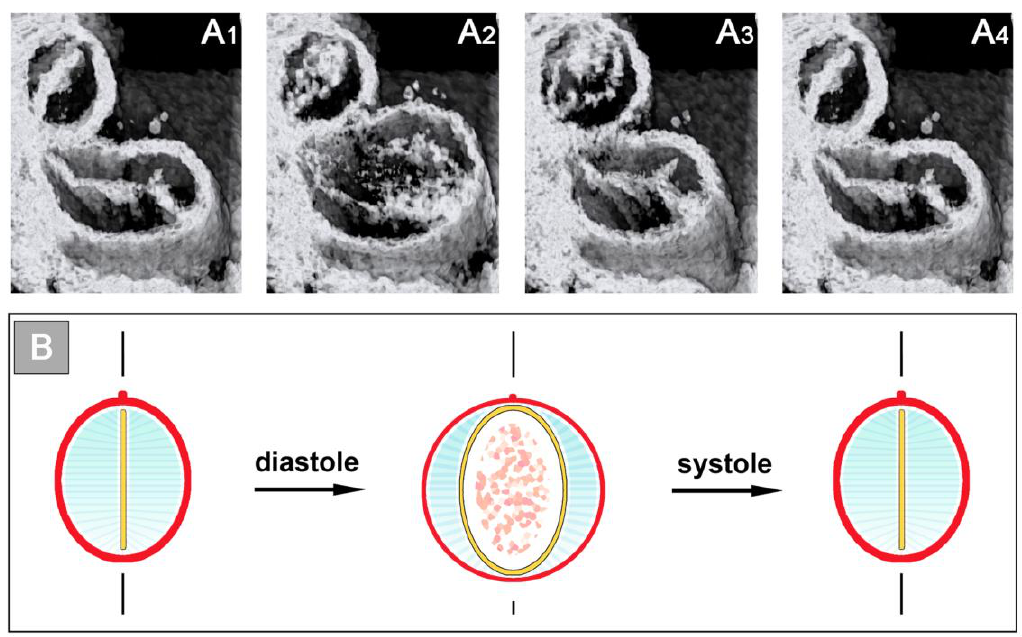
Figure 7. Cardiac cycle-related changes in the cross-sectional shape of the primary ventricular tube as visualized ( A ) by in vivo 4D OCT imaging of a HH-stage 12/13 chick embryo heart (see Figure 6C); and shown ( B ) by schematic drawings (same color code as used in Figure 2). Note that, due to the non-uniform spatial distribution of the CJ, the endocardial tube does not show concentric widening and narrowing during the cardiac cycle. The opened endocardial tube has an elliptic cross section, while the collapsed endocardial tube has a slit-shaped cross section. Note also the cyclic changes in the thickness of the CJ layer. The CJ undergoes thinning during relaxation of the surrounding myocardial wall (diastole) and thickening during contraction of the myocardial wall (systole).